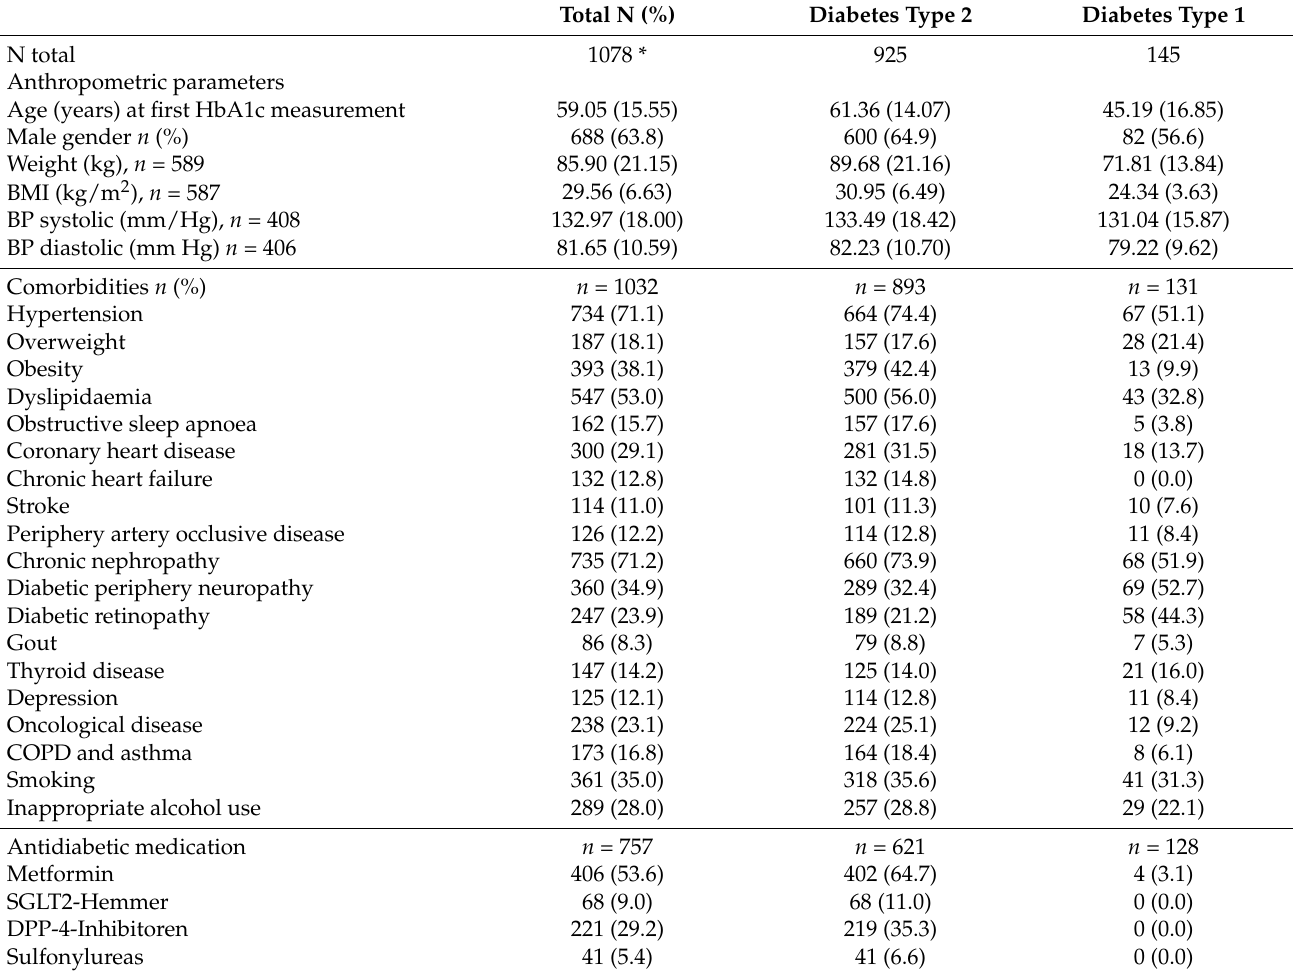
Table 1. Patients’ Characteristics before the